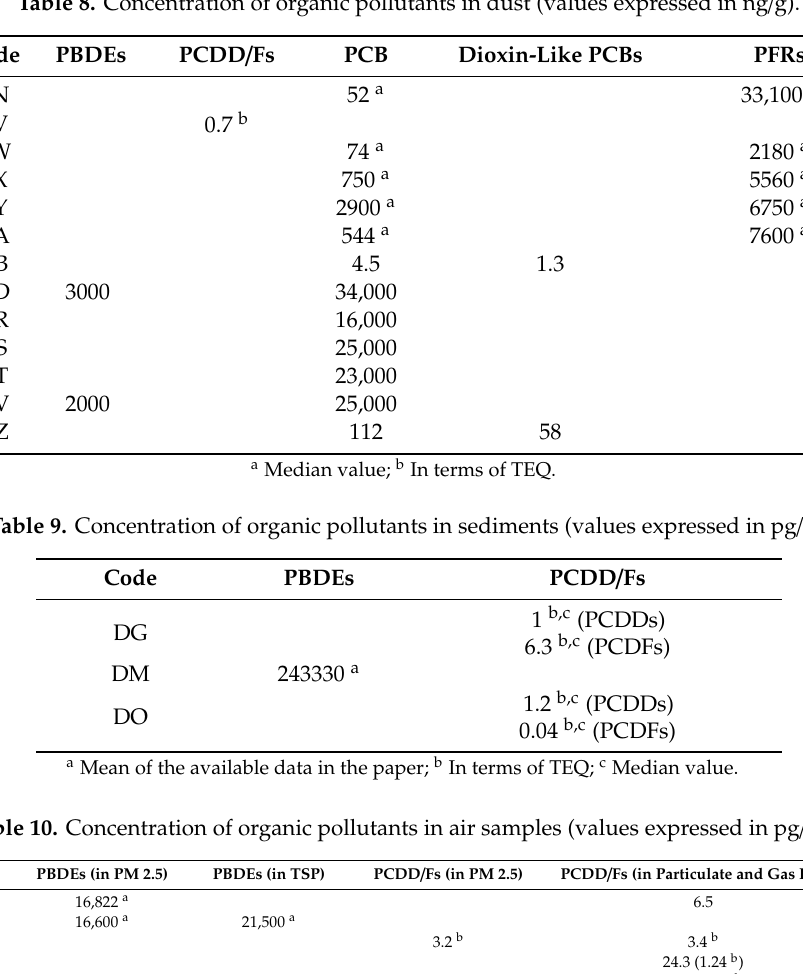
Table 8. Concentration of organic pollutants in dust (values expressed in ng / g).